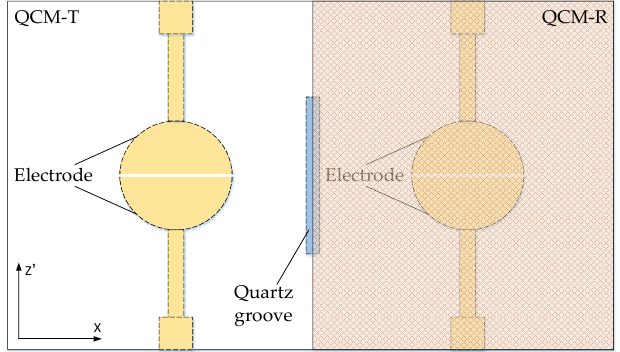
Figure 2. Schematic structure of the dual-channel LFE-QCM.